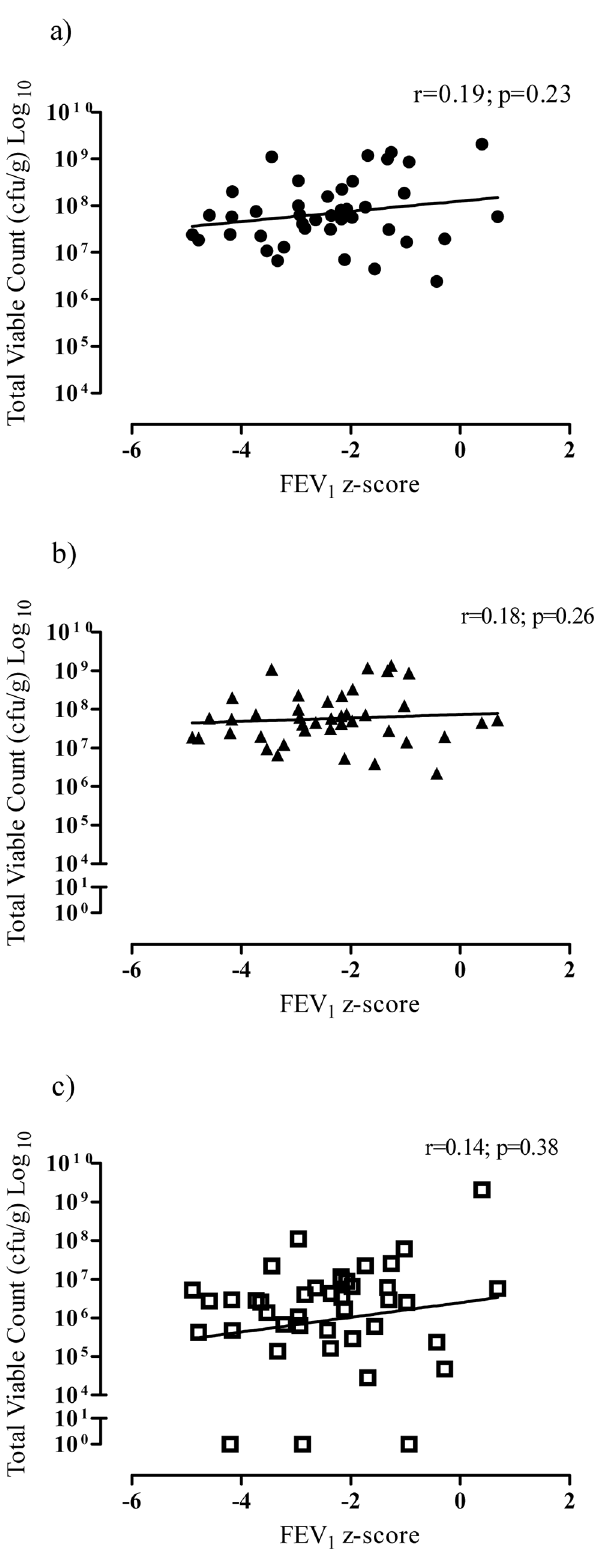
Fig 3. Relationship between FEV 1 z-score and a) total colony count b) aerobic colony count and c) anaerobic colony